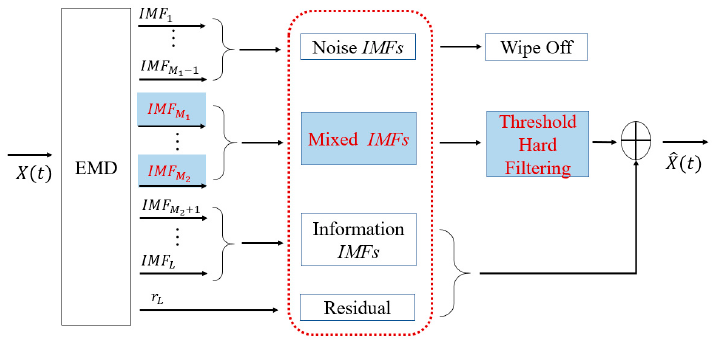
Figure 2. The reconstruction scheme of the optimal signal.